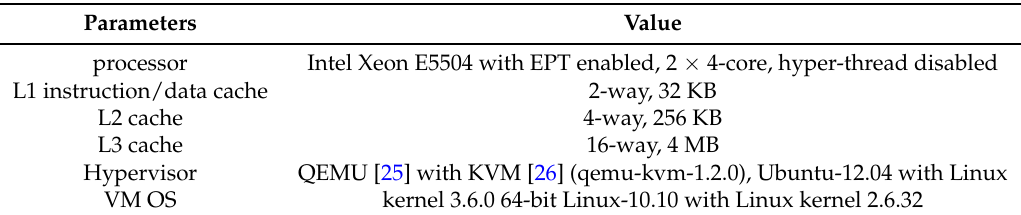
Table 3. System configurations for the experiment.